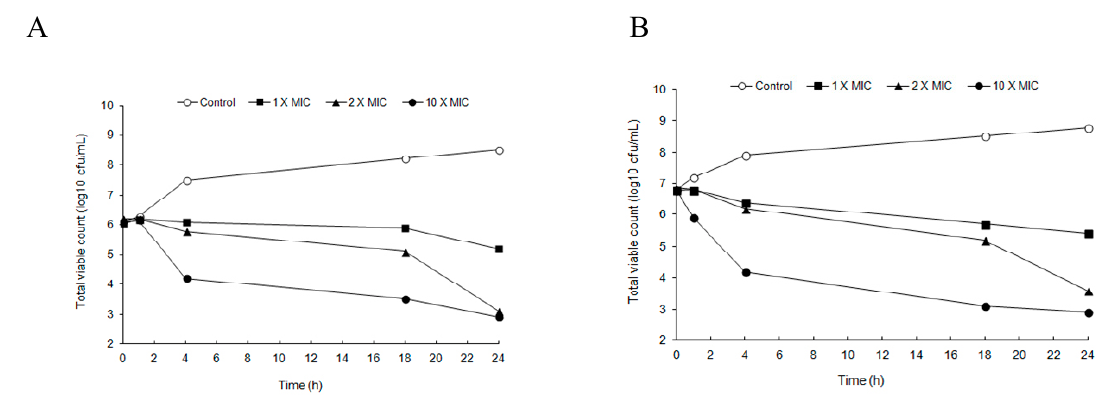
Figure 1. Time-kill curve showing the in vitro bactericidal effect of BV on Methicillin-resistant Staphylococcus aureus MRSA 3366 ( A ) and MRSA 3708 ( B ).